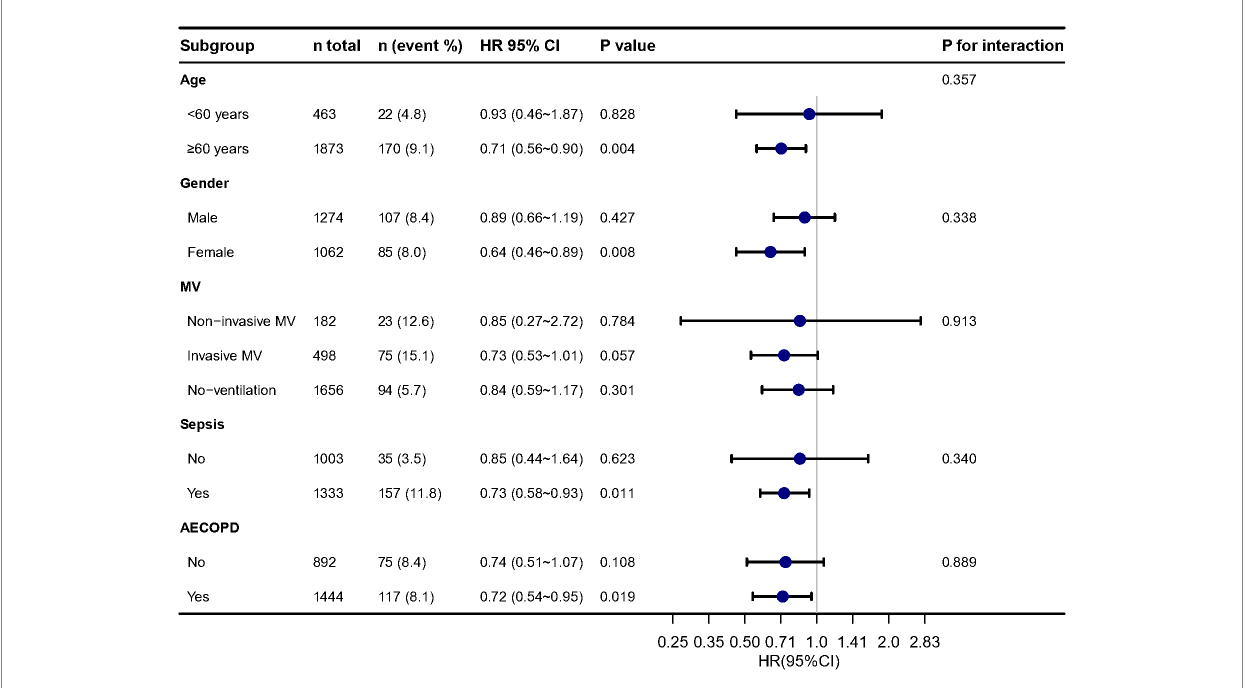
FIGURE 3 Stratified analysis of relationship between serum albumin and in-hospital mortality. Adjusted for all cofounders in Table